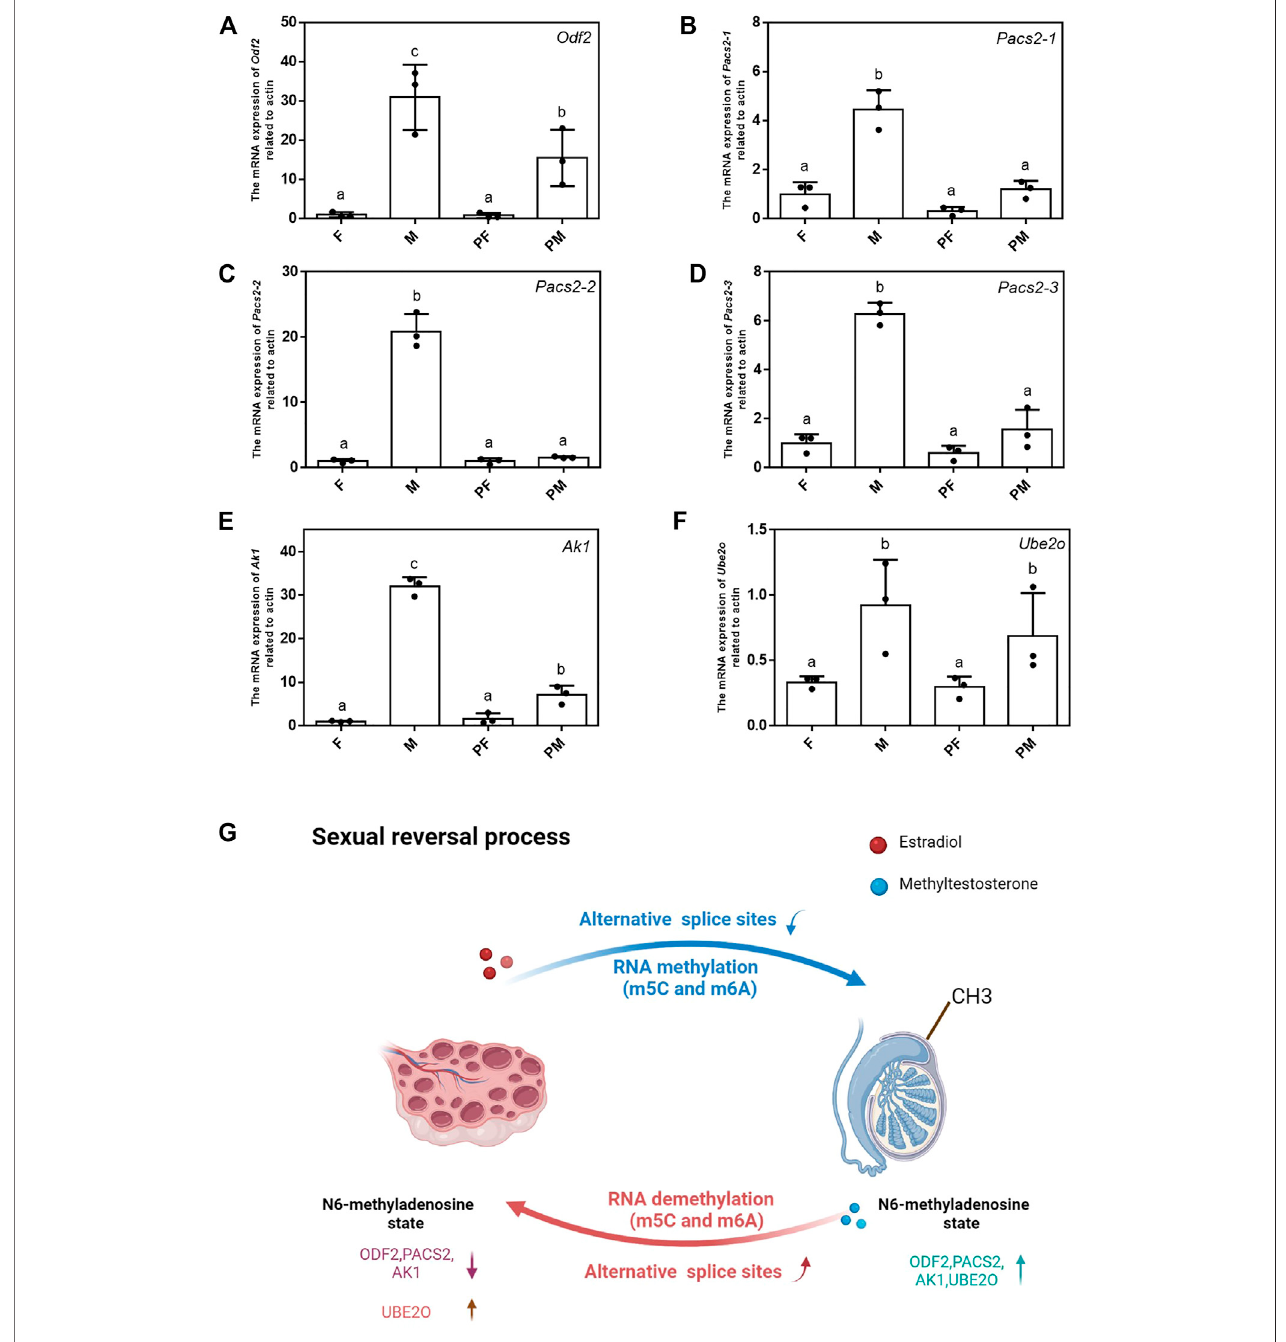
FIGURE7| Veri fi cation ofN6-methylation modi fi cation sites ofsex-relatedgenes. (A – F) ThemRNA expression levelof Odf2,Pacs2-1, Pacs2-2, Pacs2-3, Ube2o, Ak1 relatedtoactinamong4types.Datawereexpressedasmean±SD.Differentsuperscriptsindicatesigni fi cantdifference( p < 0.05). (G) Theschematicofthechanges of two sexual reversal